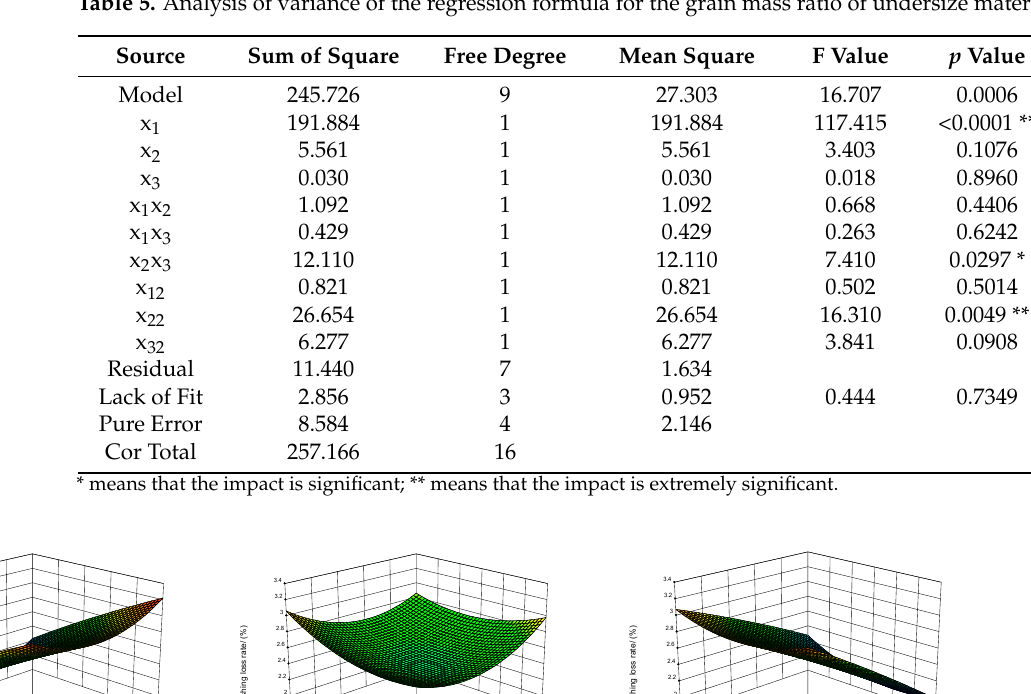
Table 5. Analysis of variance of the regression formula for the grain mass ratio of undersize material.